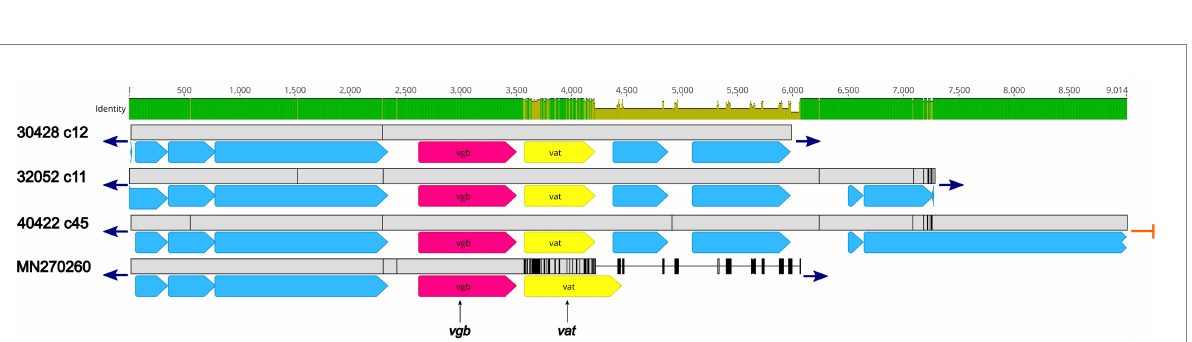
FIGURE 4 Genomic organization and alignment of the region containing the vgb and vat genes. The S. suis isolate and contig number (c) for each sequence, along with the accession number for the S. suis phage phi-SsuFJNP3_rum shown at right. Base pair numbers are displayed above the black bar at top. Green and yellow shaded bar below depicts sequence similarity with green indicating 100% identity and yellow indicating lower identity. Grey bar in between each aligned sequence region depicts sequence similarity between each sequence with grey indicating nucleotide positions with 100% identity. Blue arrows at end of grey bars indicate contig sequence continues and orange bars indicate end of contig sequence. AMR gene elements are listed below and indicated by pink ( vgb ) and yellow ( vat ). All other CDSs are indicated by light blue. Predicted incomplete CDSs are indicated by jagged ends. Accession number MN270260 is a complete nucleotide sequence from S. suis phage phi-SsuFJNP3_rum harbored by S. suis strain PJNP3, isolated from a